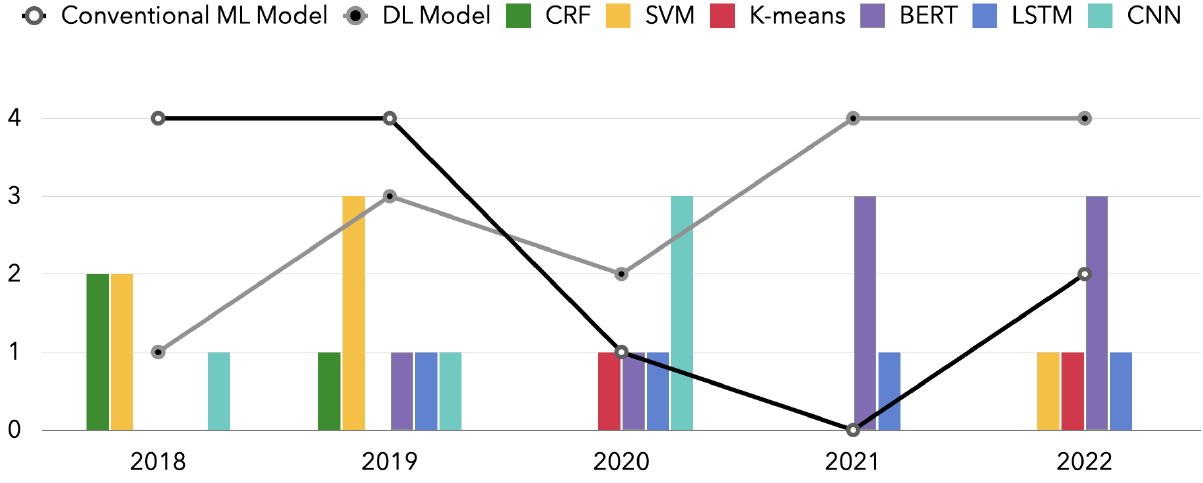
Figure 11. The number of NLP models over years: a comparison of conventional ML model and DL model